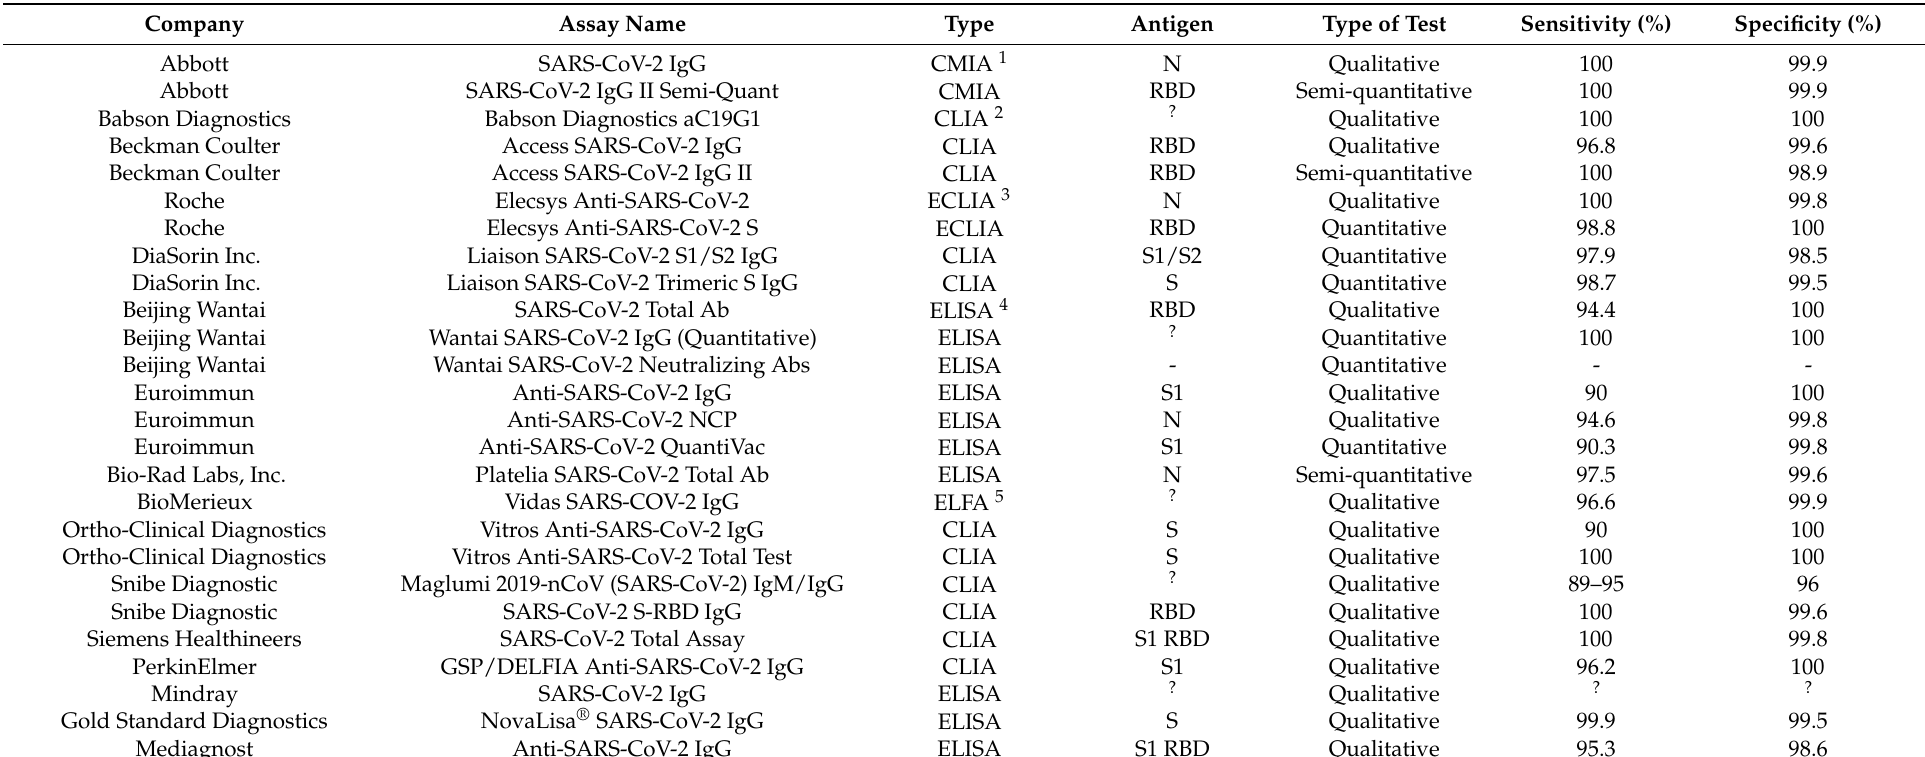
Table 1. Approved SARS-CoV-2 IgG